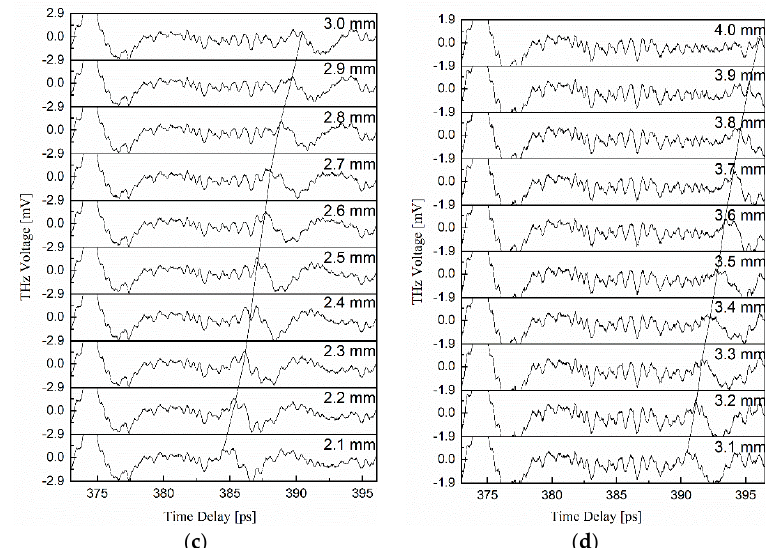
Figure 7. THz time ‐ domain spectra of the hollowing deterioration samples. The thickness of the hollowing deterioration samples in ( a ) are 0.1 to 1.0 mm at 0.1 ‐ mm intervals. The thickness of the hollowing deterioration samples ( b ) are 1.1 to 2.0 mm at 0.1 ‐ mm intervals. The thickness of the hollowing deterioration samples ( c ) are 2.1 to 3.0 mm at 0.1 ‐ mm intervals. The thickness of the hollowing deterioration samples ( d ) are 3.1 to 4.0 mm at 0.1 ‐ mm intervals.